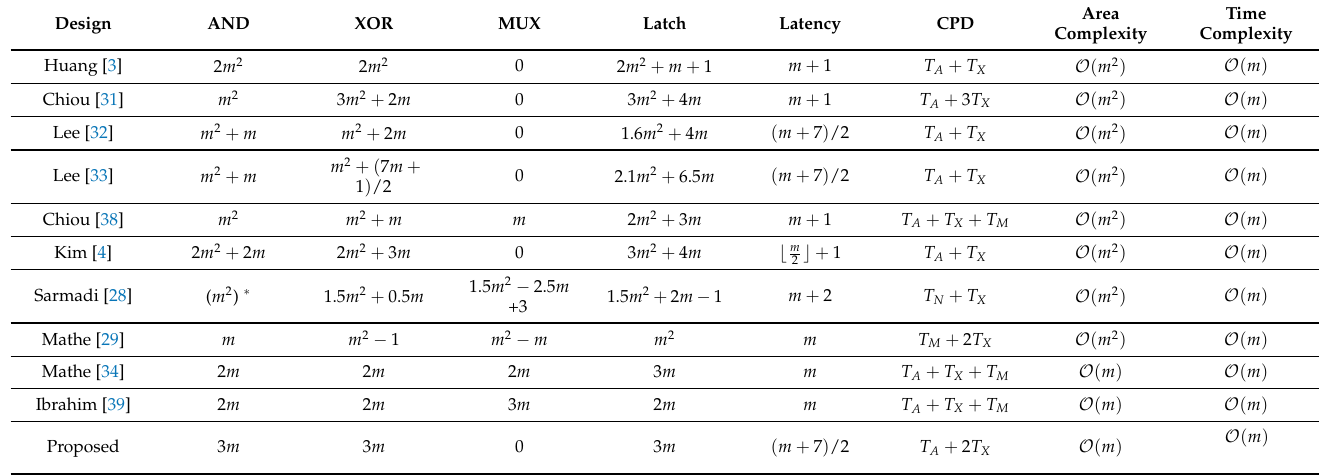
Table 1. Complexity analyses in terms of area and time of the suggested and the existing multipliers.